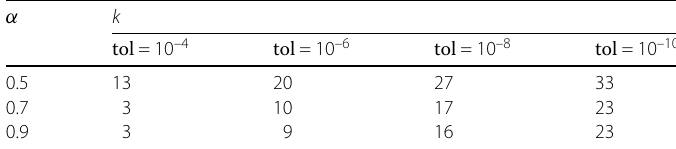
Table 4 INVERSE-FREE iterative Algorithm 4.3 α